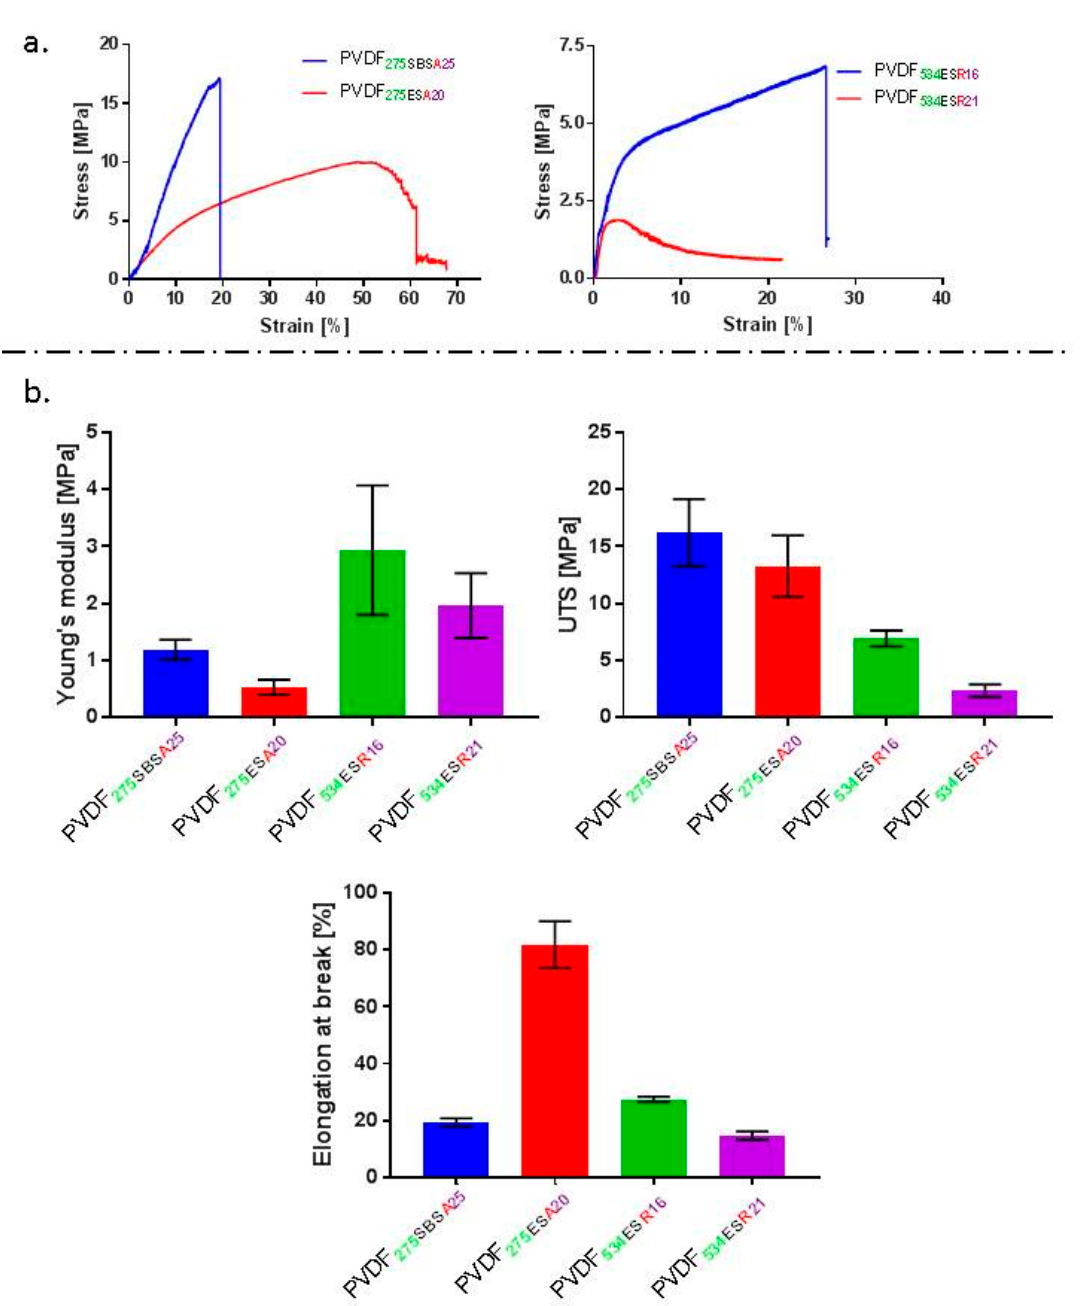
Figure 2. ( a ) Representative stress-strain curves for different fibres fabricated using SBS and ES, ( b ) graphs presenting values calculated for different mechanical properties such as Young’s modulus, ultimate tensile strength (UTS) and elongation at break for fabricated fibres.